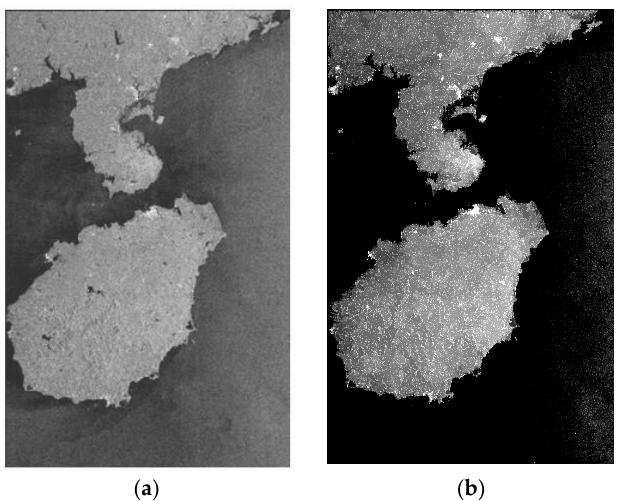
Figure 5. Synthetic aperture radar (SAR) image: ( a ) Original SAR image; ( b ) SAR image after gray transformation.